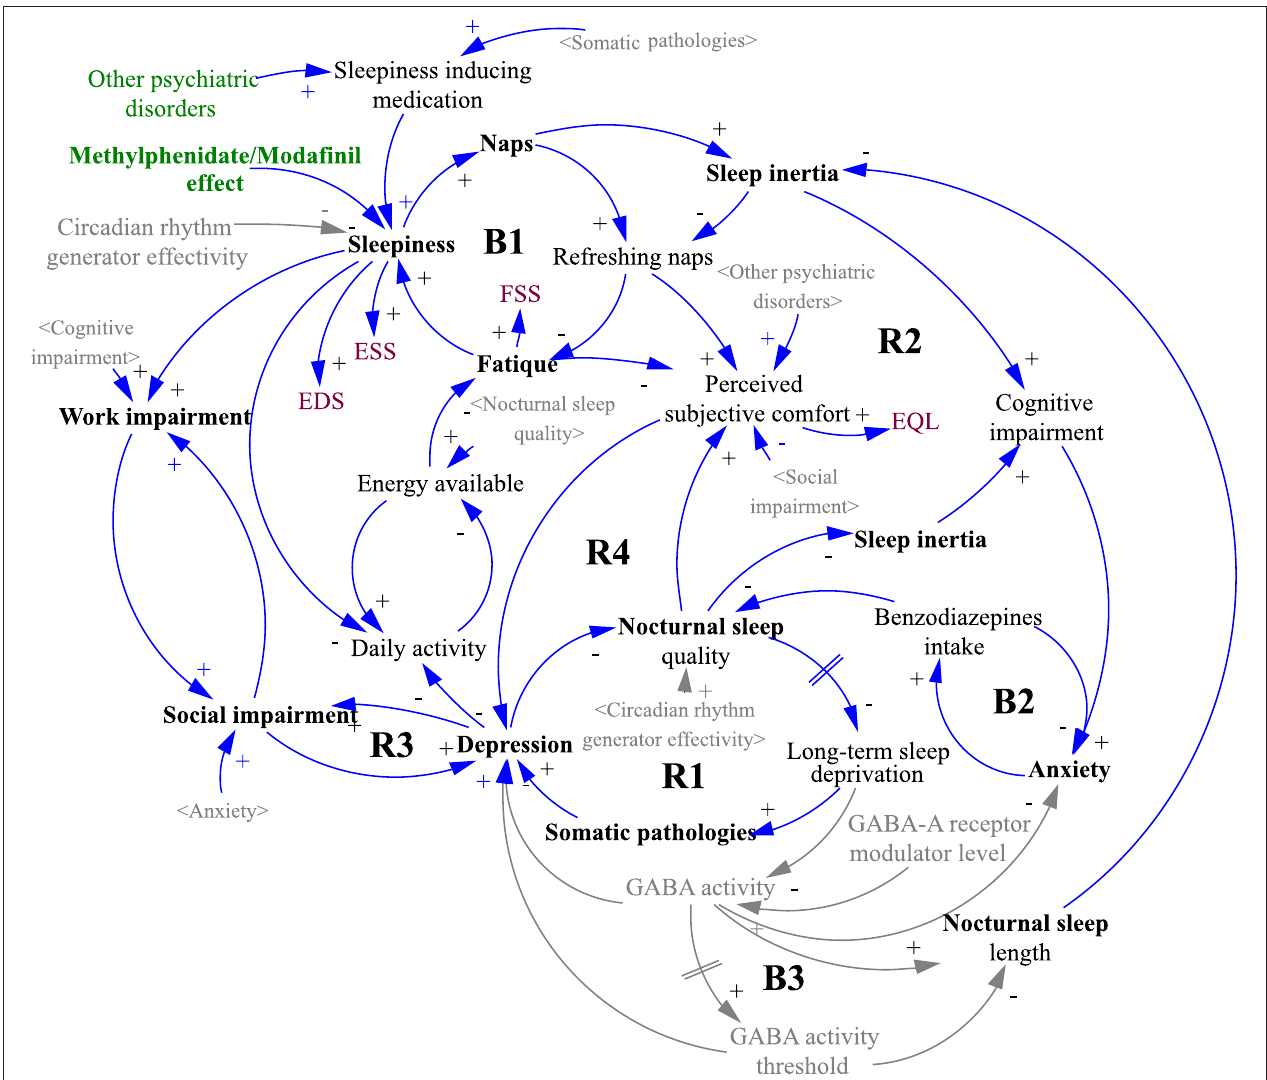
FIGURE 2 | Causal loop diagram of the simulation model structure. The gray variables in sharp brackets <> are copies of the black originals and are used to increase the clarity of the diagram. The gray variables without brackets and the gray causal links were not included in the simulation, indicating a possible direction for further model development. A detailed description of the diagram logic is given in the Results